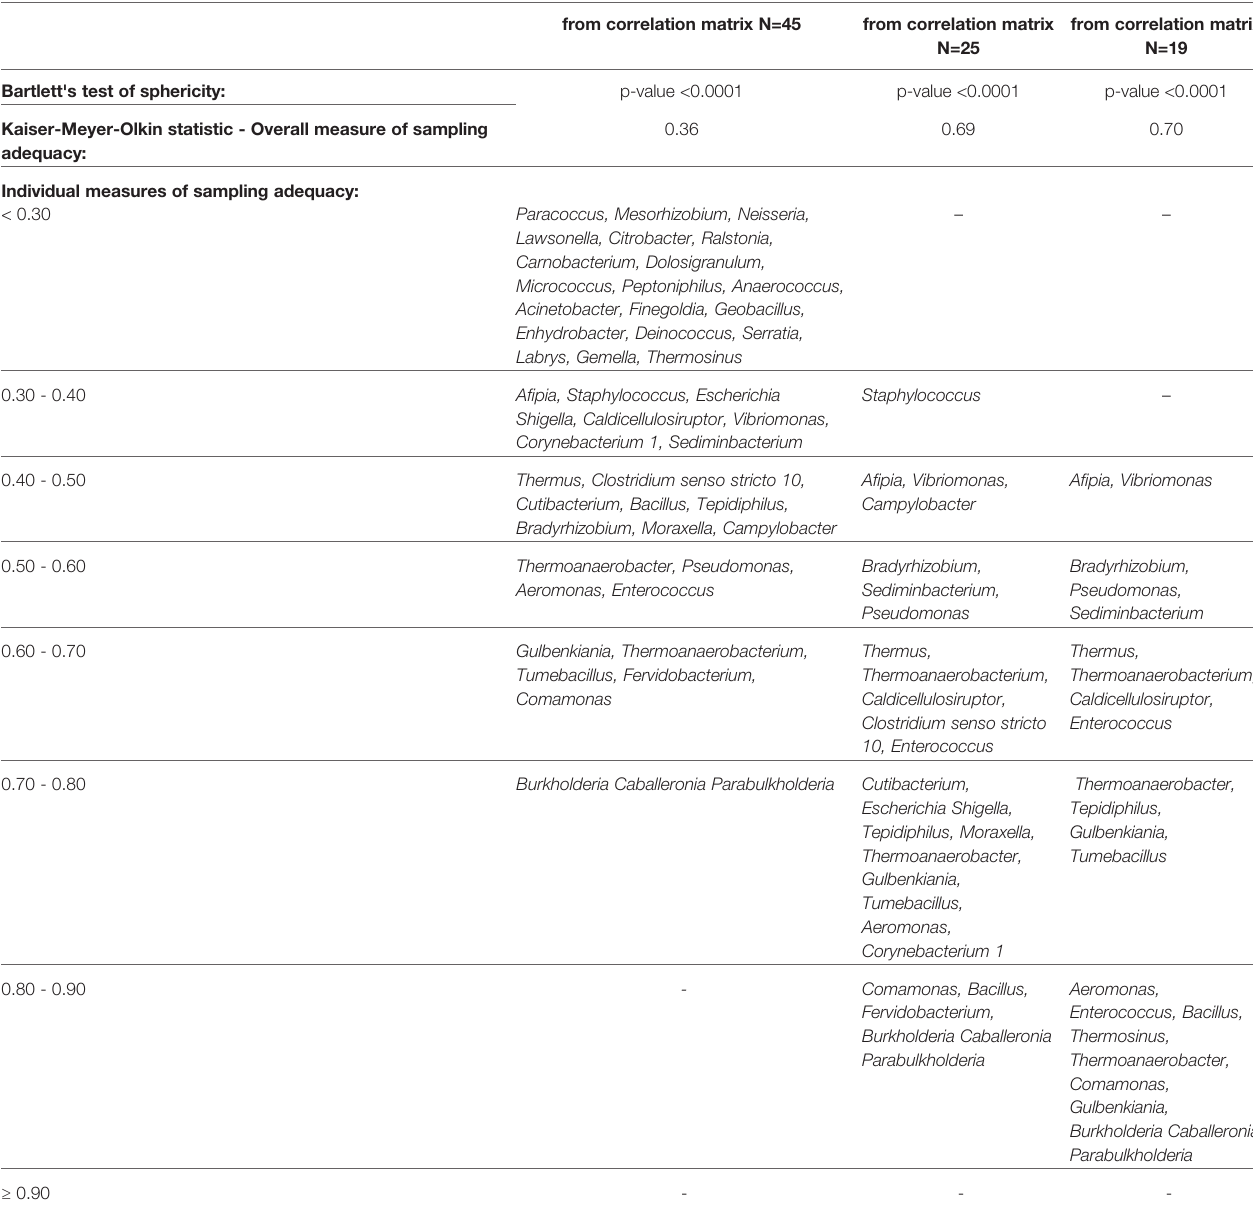
TABLE 1 | Factorability of the correlation matrix of the log-transformed genera: Bartlett ’ s test of sphericity and measures of sampling